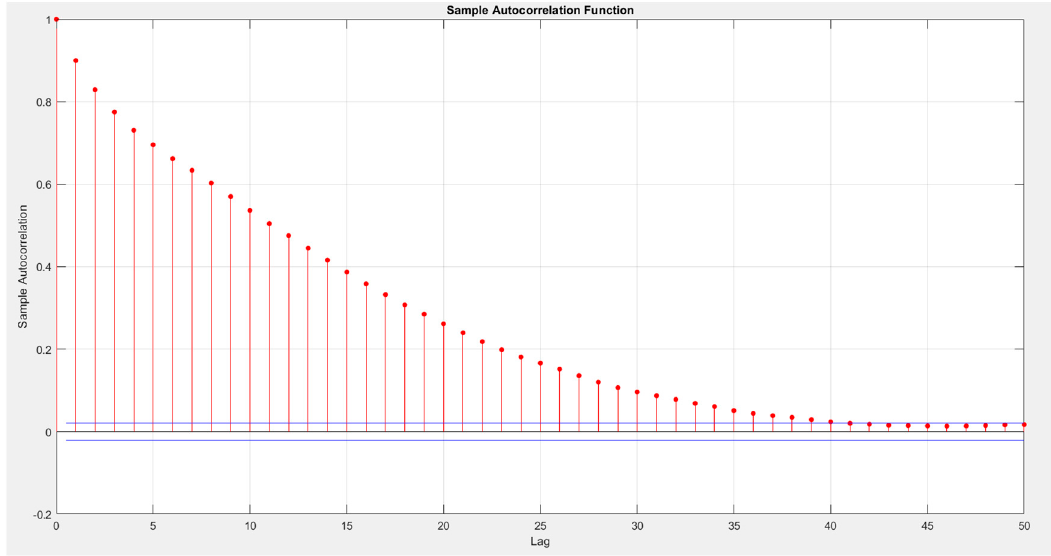
Figure 4. Example of the results of the autocorrelation function.